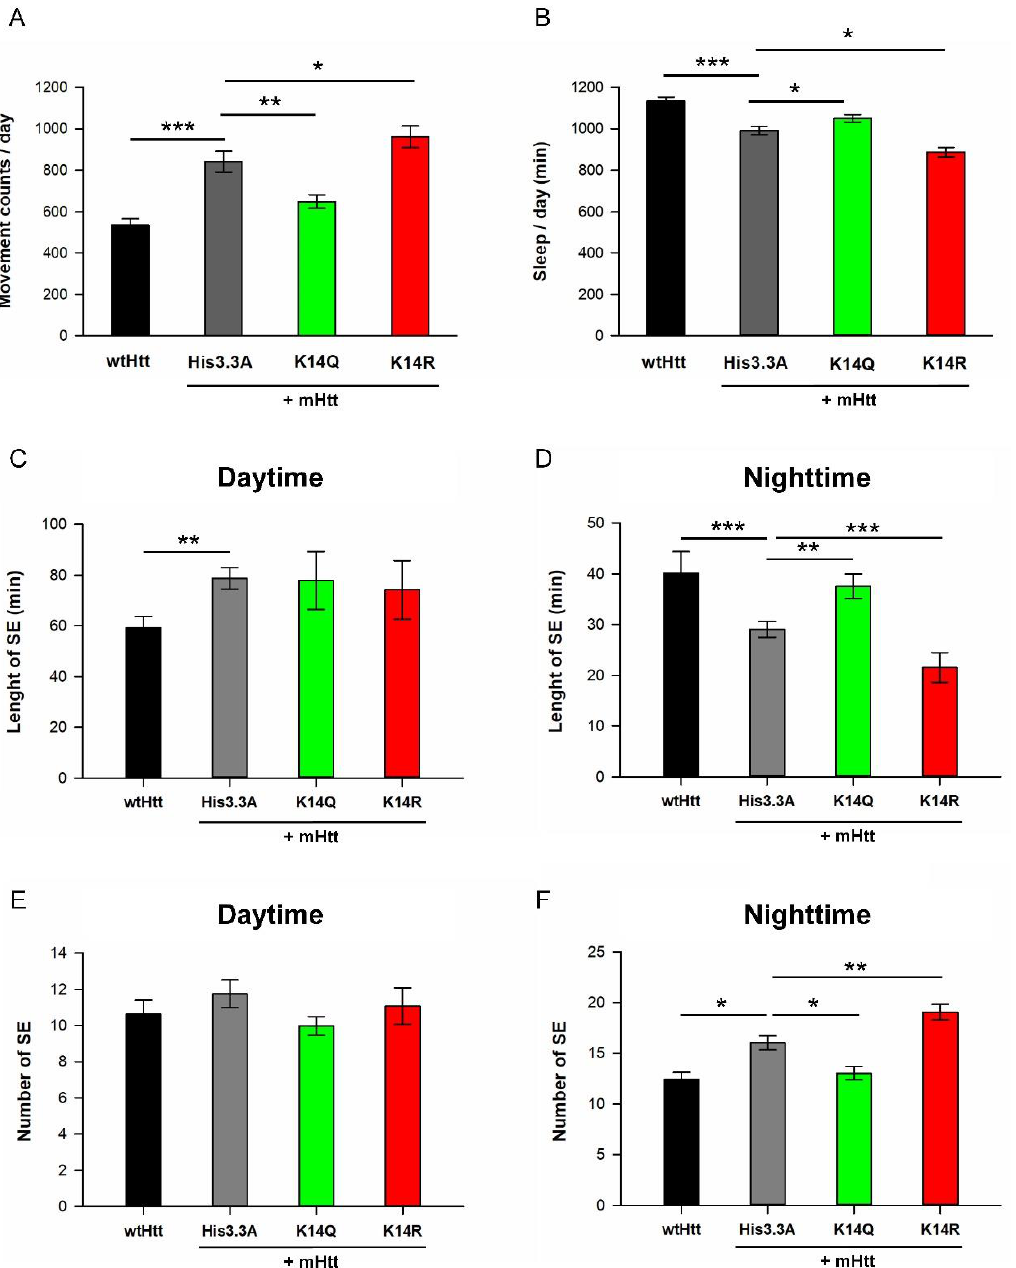
Figure 5. Adult expression of K14Q mutant H3.3 suppressed disturbed daily activity and sleep phenotypes in HD flies, while expression of the K14R mutant enhanced them. ( A ) Total daily movement counts of male flies expressing wtHtt or co-expressing mHtt + His3.3A transgenes in the adult nervous system under the influence of elav-GAL4 ; tubGAL80 ts with heterozygous His3.3A KO background. Co-expression of mHtt and His3.3A leads to hyperactivity (increased movement counts) compared with flies expressing Huntingtin with 25 glutamines ( wtHtt ). Expression of His3.3A-K14Q suppressed hyperactivity of HD flies compared with His3.3A -expressing control flies, while expression of His3.3A-K14R enhanced it. The graph shows the average of the total number of movements during a 24 h time period; the error bars represent the standard error. ( B ) Total amount of daily sleep of